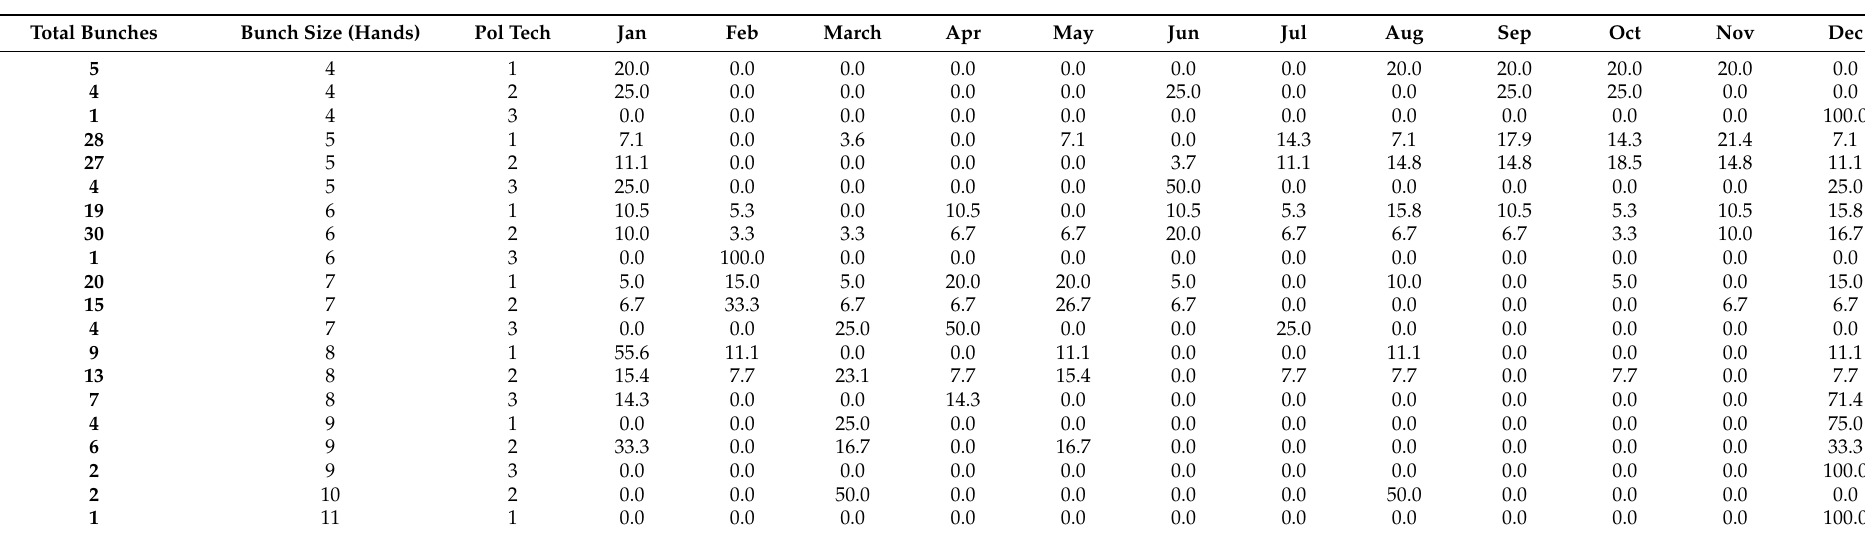
Table A7. Percentage bunch distribution by month of pollination in “Nshonowa” pollinated with “Calcutta 4”, using different pollination techniques, between January 2016 and January